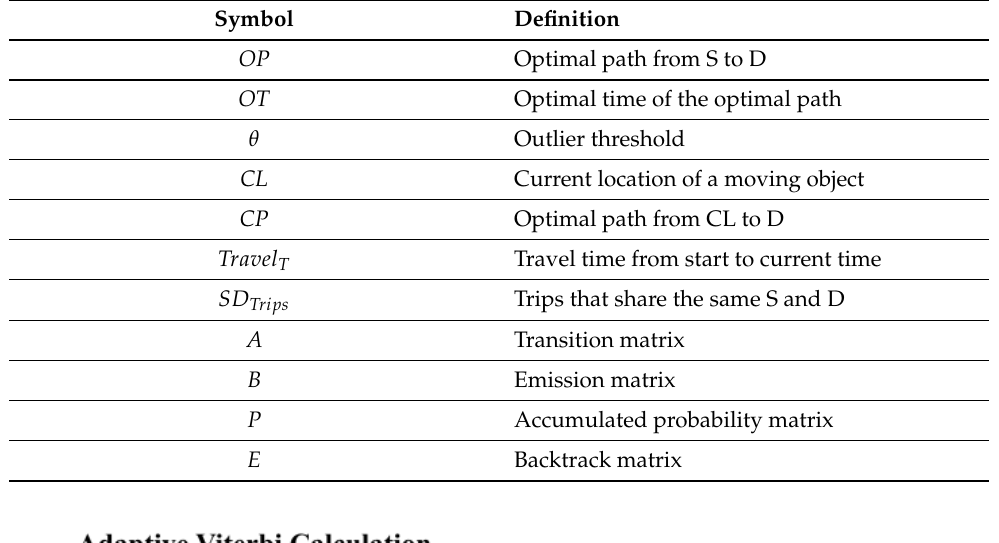
Table 1. List of notations used in this paper.